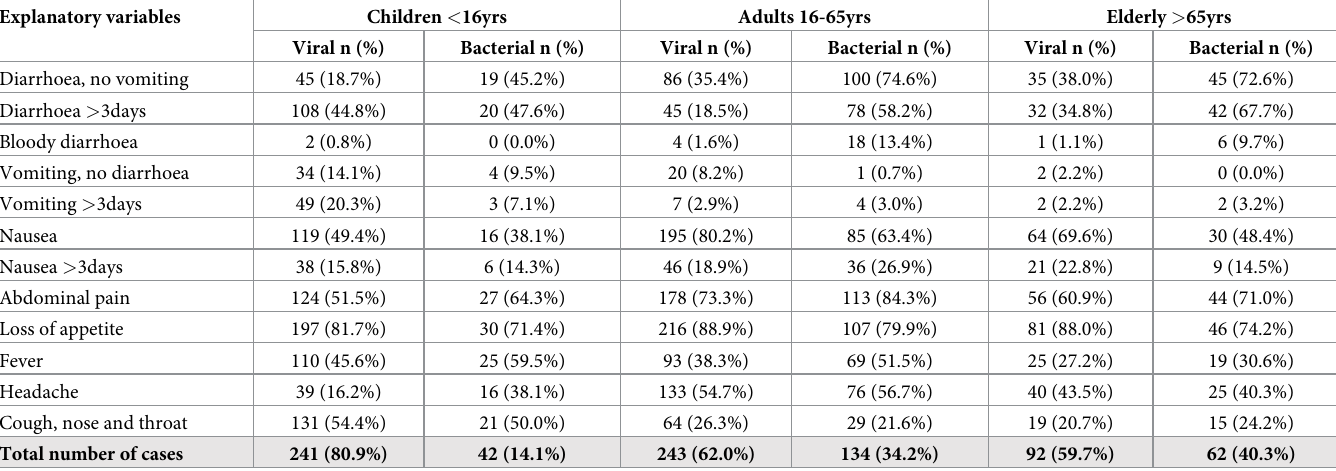
Table 3. Number and percentage of reported symptoms, by age and